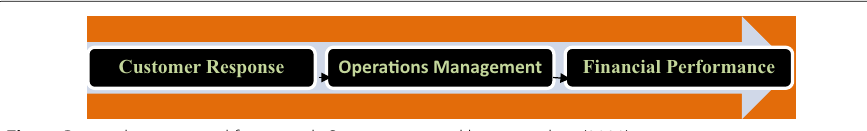
Fig. 1 Research conceptual framework. Source: prepared by researcher,